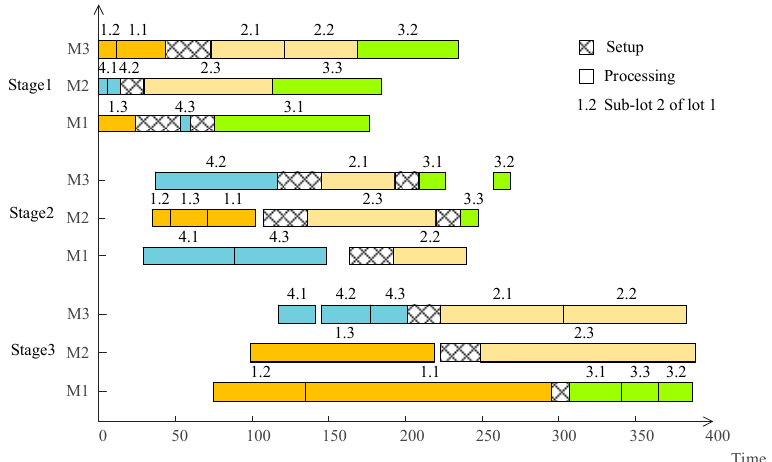
Figure 9. A scheduled Gantt chart for the